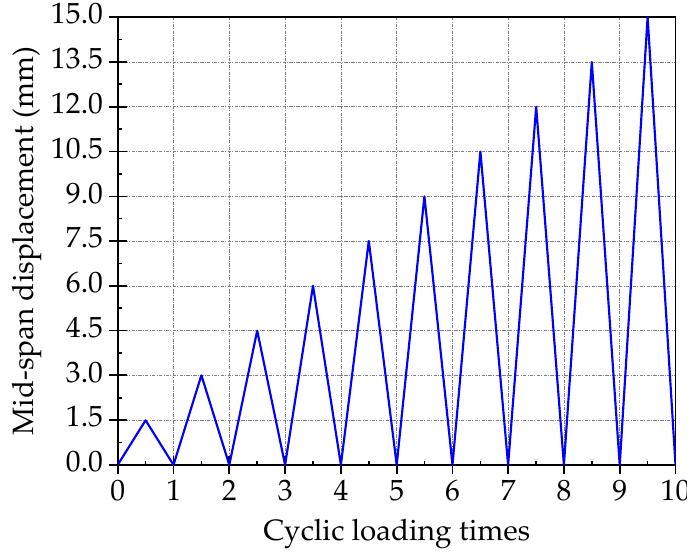
Figure 7. Monotonic cycle loading protocol.